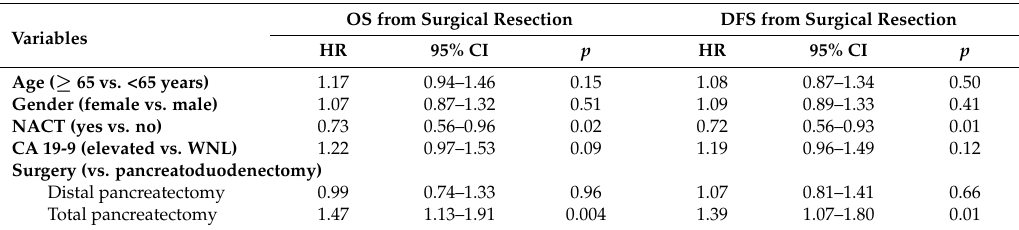
analysis with the inclusion of the conversion surgery after NACT group and upfront surgery group.